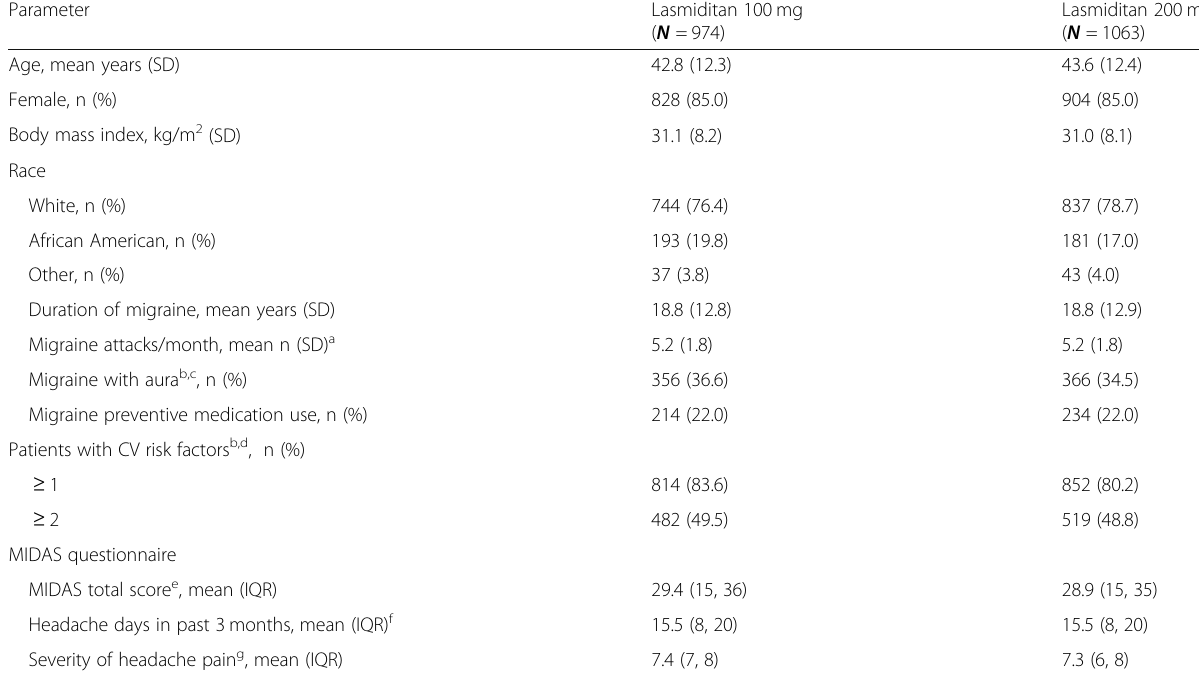
Table 1 Baseline characteristics by lasmiditan dose for the GLADIATOR MIDAS population